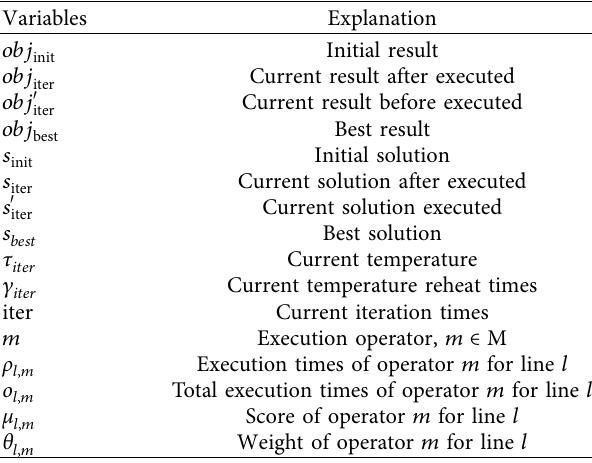
Table 7: The explanation of MOSA algorithm-related variables.